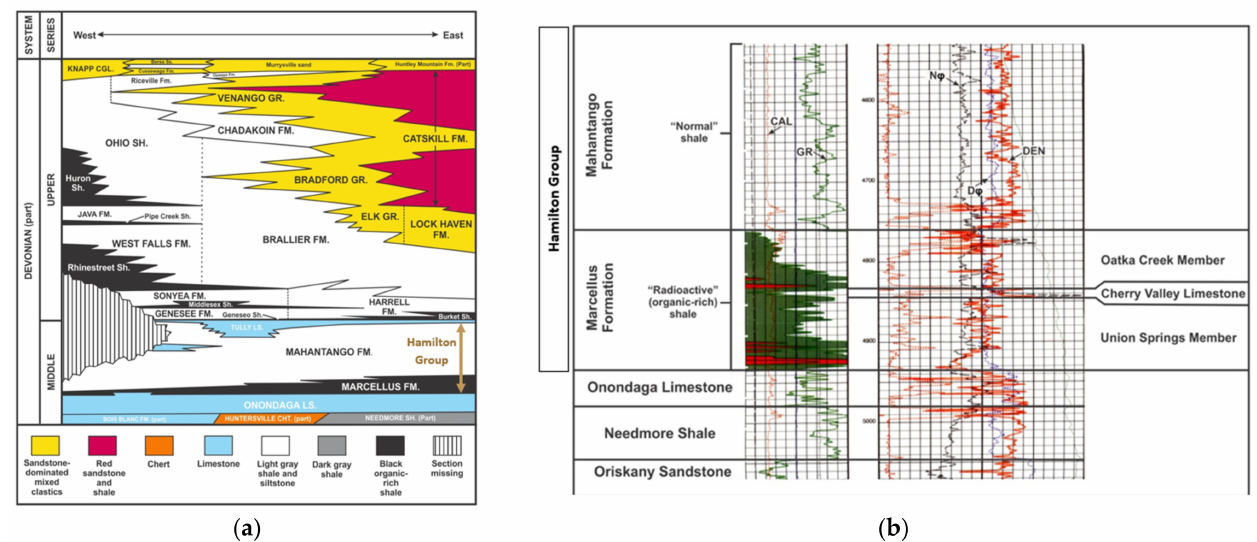
Figure 2. ( a ) Correlation diagram of Middle and Upper Devonian stratigraphic intervals in western and north-central Pennsylvania. From Carter et al. [20]. Also see Harper et al. [21] and Carter [22]. Stratigraphic units above the Middle Devonian Onondaga Limestone comprise the siliciclastic succes- sions of the Castskill Delta. FM.—Formation; SH—Shale; GR—Group; LS—Limestone; CHT—Chert. ( b ) Diagram of parts of a wireline geophysical log showing the stratigraphic nomenclature for the Marcellus Formation in the subsurface of Pennsylvania. From Carter et al. [20]. CAL—Caliper; GR—Gamma Ray; DEN—Bulk Density; NØ—Neutron Porosity; DØ—Density